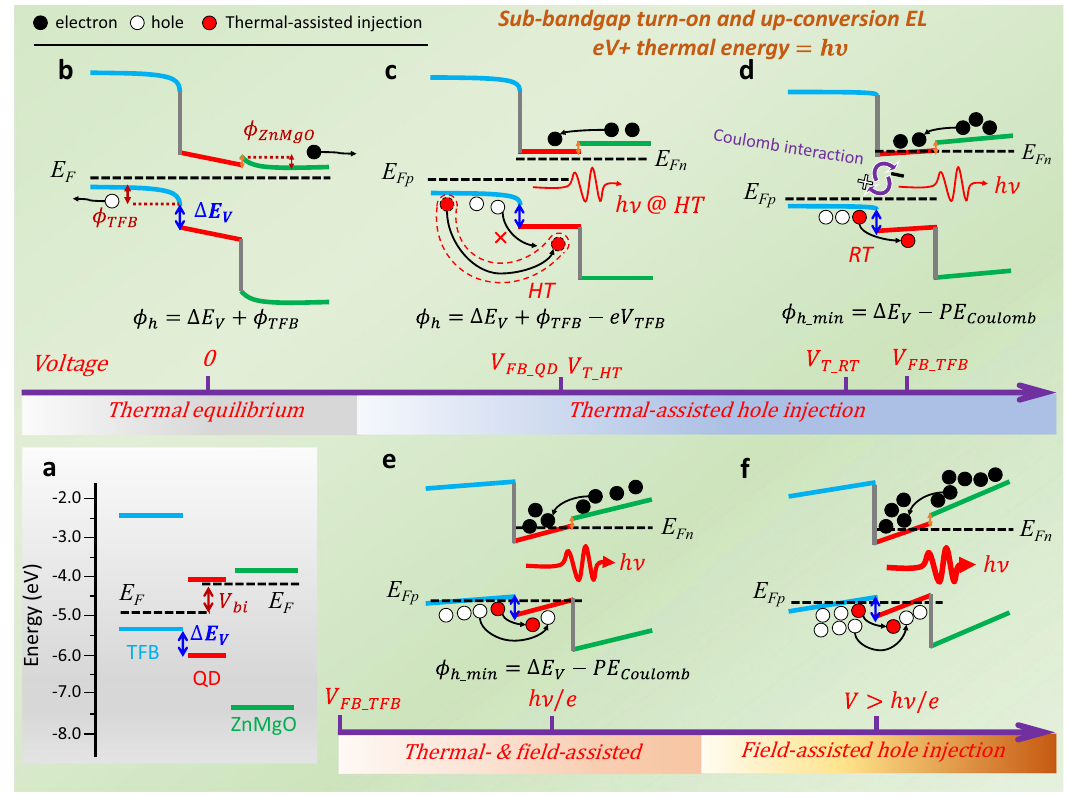
Fig. 2 Charge injection processes in QLEDs. a Energy levels of the functional layers of the typical red-QLEDs. b At thermal equilibrium, the surfaces of TFB and ZnMgO are depleted so that the Fermi levels are aligned through the system. Due to the presence of build-in surface potentials ( ϕ charge injection is impossible. c At V FB QD , fl at-band is achieved in QD layer and thus electron injection into QDs is possible, while hole injection is still unfavorable due to the large injection barrier ϕ h . However, at high temperature (HT), with suf fi cient thermal energy provided, holes could be injected into QDs via the thermal-assisted thermionic-emission mechanism. d At V FB TFB , fl at-band is achieved in TFB layer, and the hole injection barrier is reduced to a minimum value of ϕ h ¼ 4 E V (cid:3) PE Coulomb . At RT, with the assistance of thermal energy, the holes can overcome a barrier of 0.4 eV and injected into QDs. e At h υ = e , all depletion regions are vanished and the electric fi eld in all layers turn positive, and thus the holes can be accelerated towards the QDs. Hole injection is enabled by both thermal- and fi eld-assisted thermionic-emission mechanisms. f At V > h ν = e , due to the presence of strong positive electric fi eld in TFB, hole injection is mainly dominated by the fi eld-assisted thermionic-emission E are the valance band levels of QDs and TFB, respec- HOMO TFB tively. Under different applied voltages, the charge injection